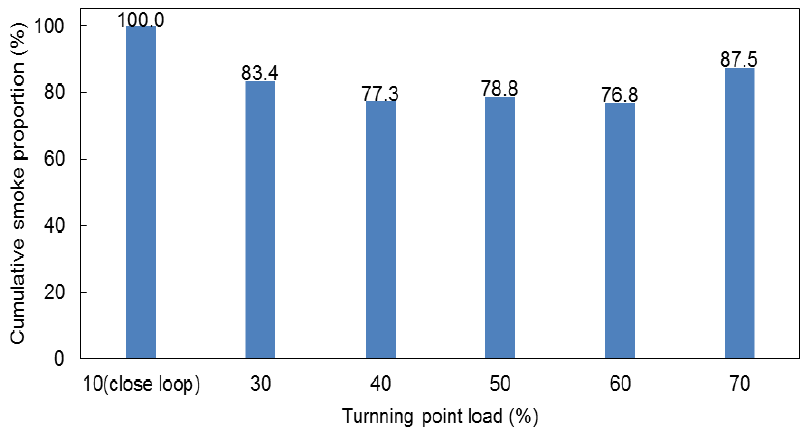
Figure 13. E ff ect of SSRP strategy on cumulative smoke proportion. Figure 13. Effect of SSRP strategy on cumulative smoke proportion. Figure 13. Effect of SSRP strategy on cumulative smoke proportion.